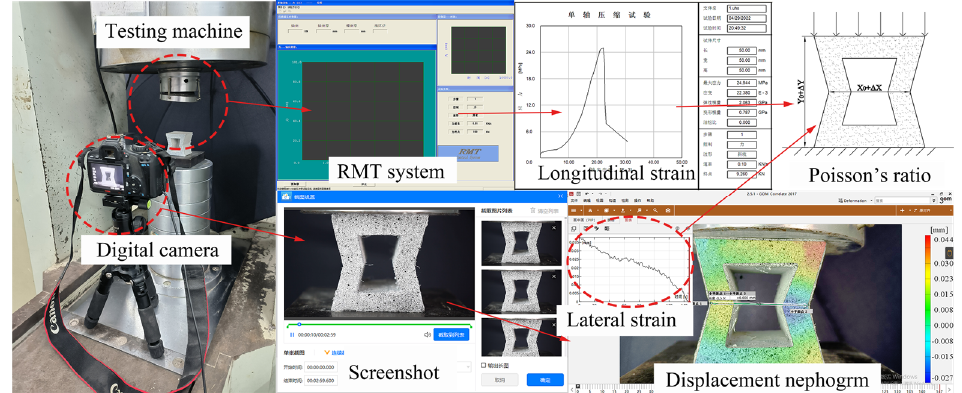
Figure 2. Experimental procedure for DSCM of the concave hexagonal unit cell.